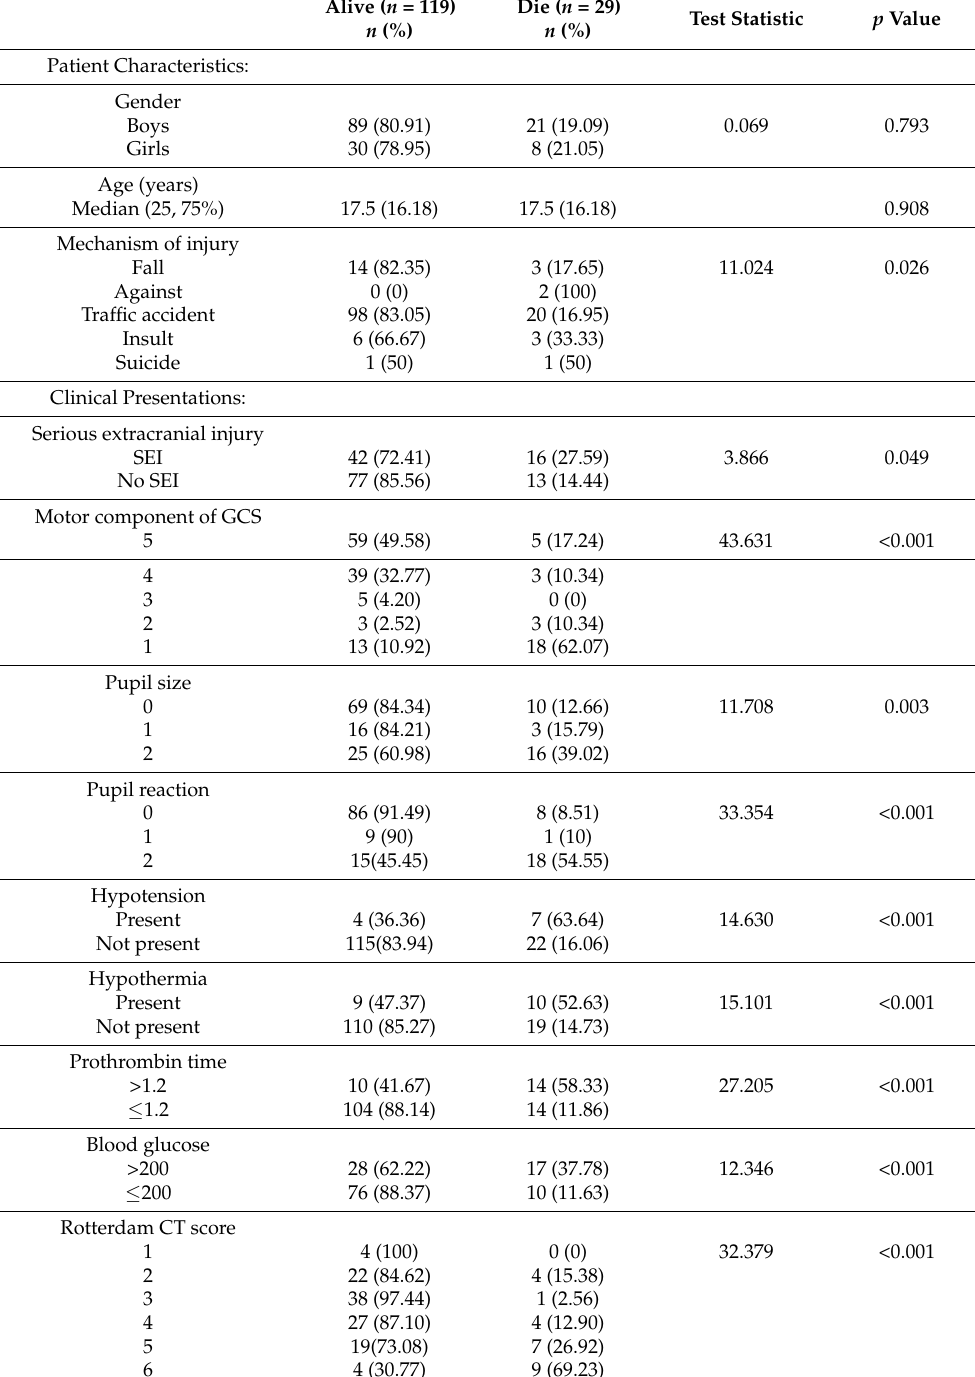
Table 2. Univariate analyses of association of mortality in children with severe traumatic brain